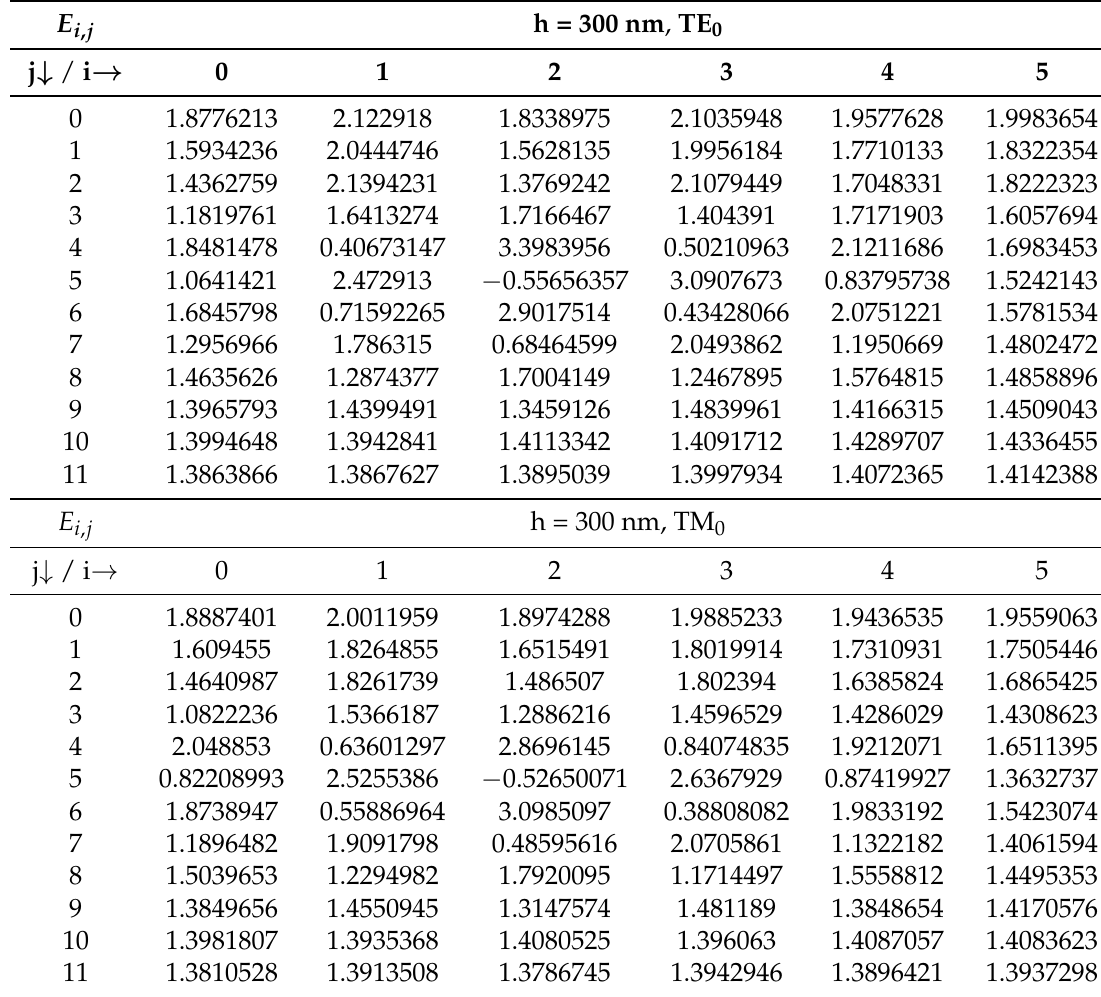
Table A2. Effective index Bézier curve coefficients for h = 300